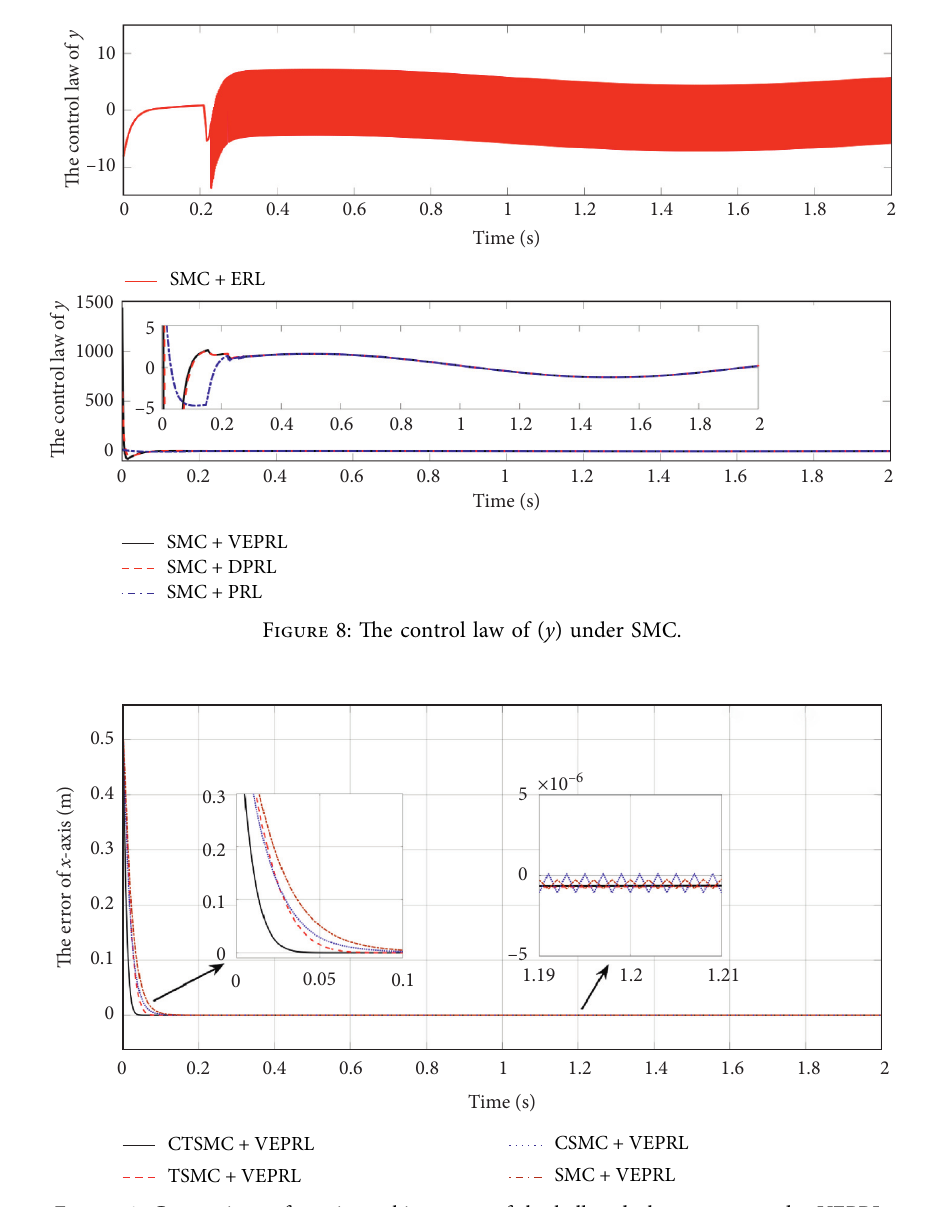
Figure 9: Comparison of x -axis tracking error of the ball and plate system under VEPRL.